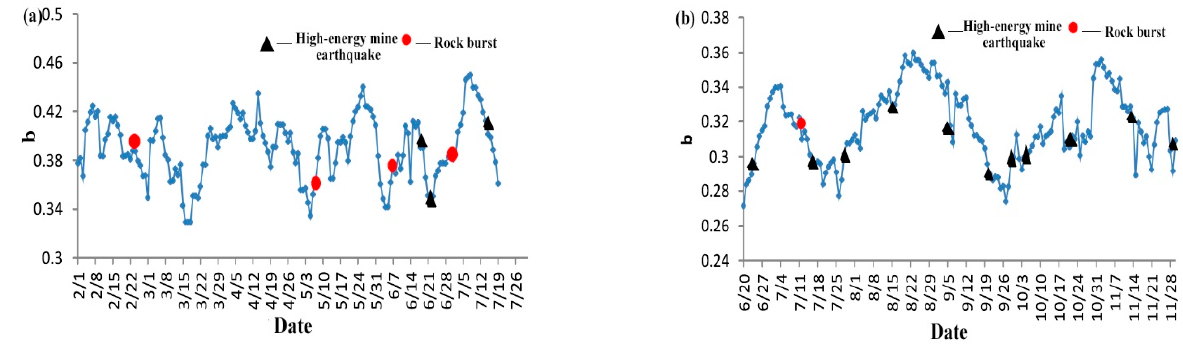
Figure 9. Microseismic b value change curve ( a ) 73005# ( b ) 83003#.